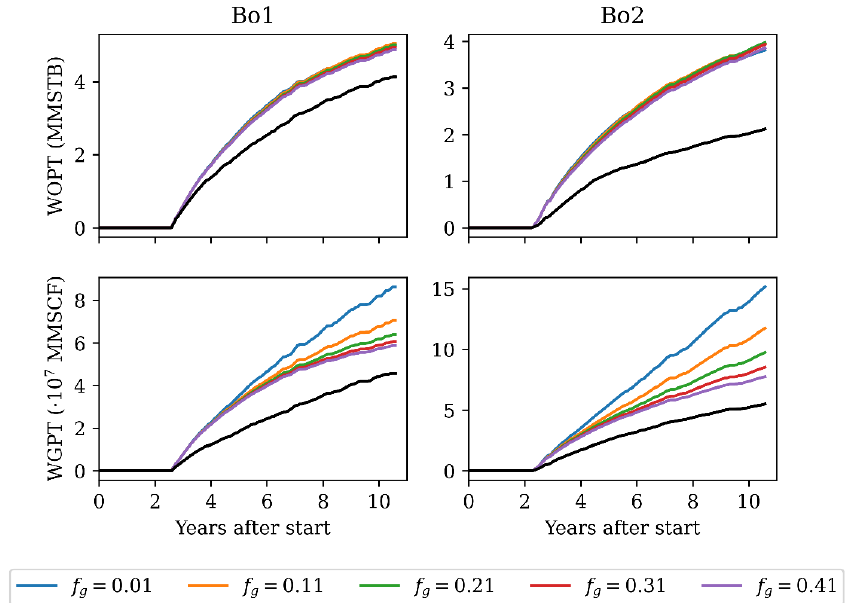
Figure 6. The production volumes for the Bo model, corresponding to the different relative permeabilities in Figure 4. Black lines denote historical data.